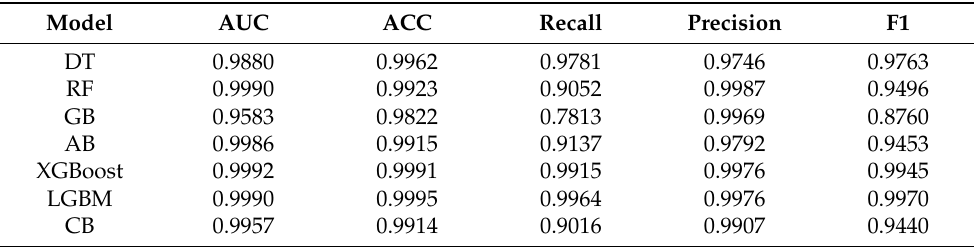
Table 6. Experiment I: Testing results of the proposed classifiers suing all the features in the origi- nal dataset.